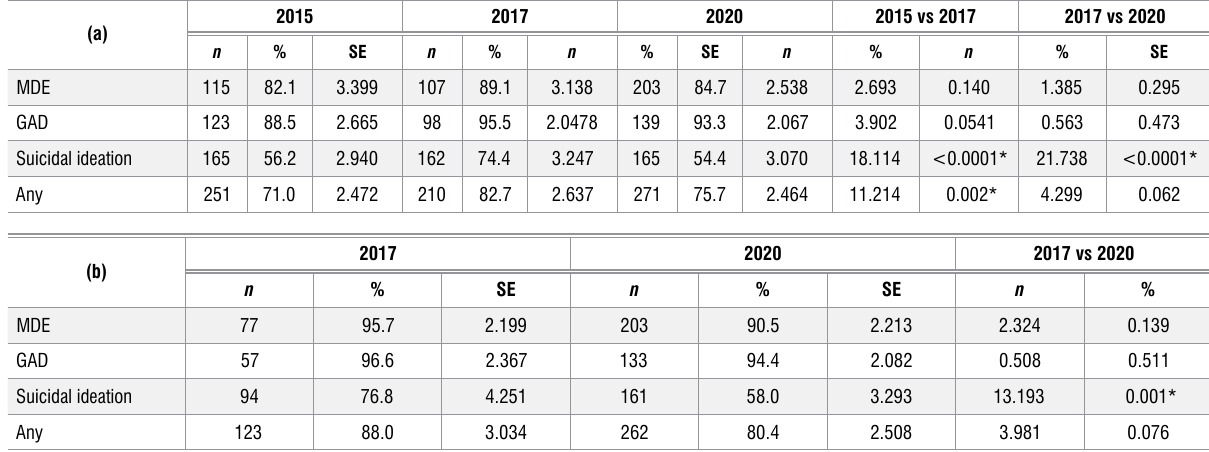
12-Month prevalence among lifetime cases of major depressive episode (MDE), generalised anxiety disorder (GAD) and suicidal ideation among the total sample of first-year students at (a) Stellenbosch University and (b) University of Cape Town, by year †